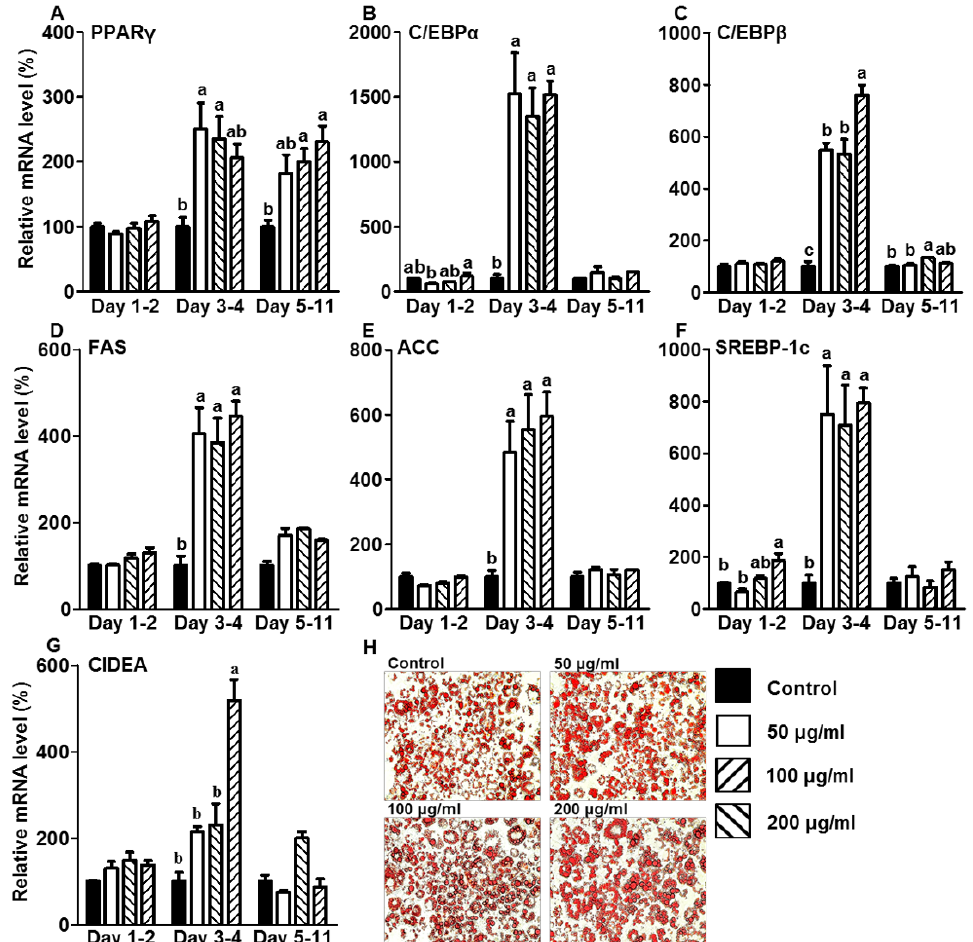
Figure 3. Effects of CE treatment at different stages of 3T3-L1 adipogenesis on adipogenic and lipogenic gene expression levels. Adipocytes were treated with CE at the preadipocyte (days 1–2), initiation (days 3–4), and post stages (days 5–11) of differentiation during adipogenesis. On day 11, the expression levels of genes related to adipogenesis ( A ) PPAR γ , ( B ) C/EBP α , ( C ) C/EBP β , and lipogenesis ( D ) FAS, ( E ) ACC and ( F ) SREBP-1c, and lipid droplet formation ( G ) CIDEA, were measured using a quantitative real-time PCR assay. ( H ) Representative images of Oil-Red O staining in fully matured adipocytes